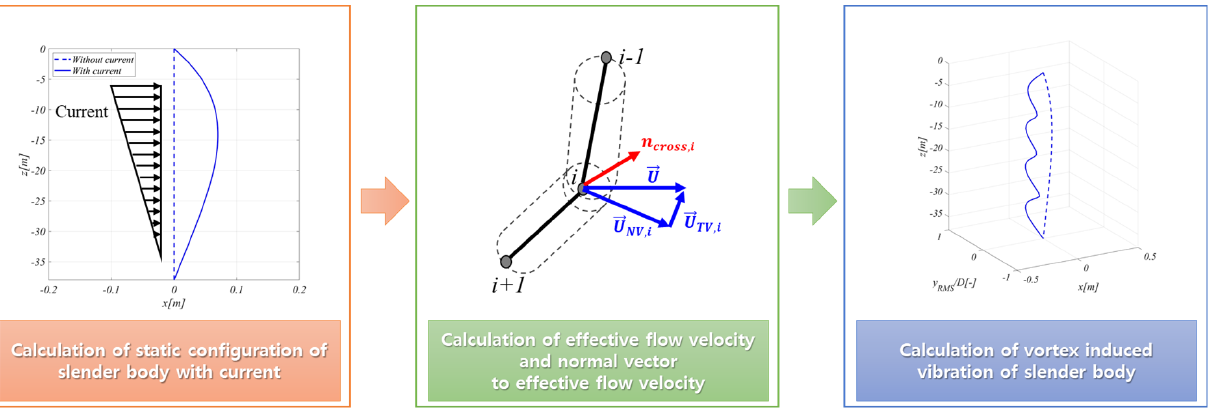
Figure 13. Calculation procedure for CF VIV of the slender body.